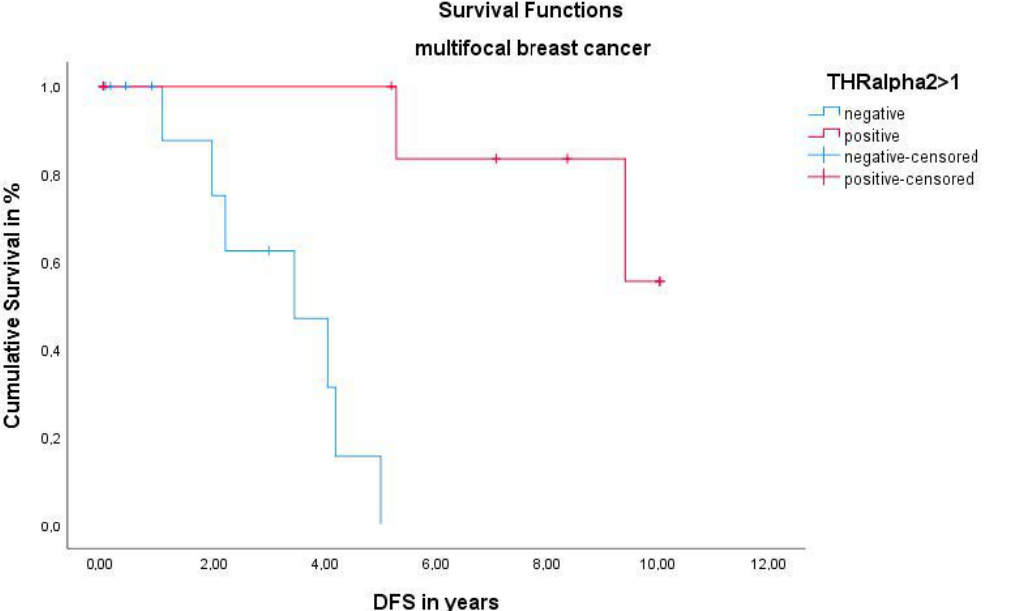
Figure 3. Kaplan–Meier survival analysis among THR α 2 positive and negative patients. DFS of patients with multifocal and/or multicentric